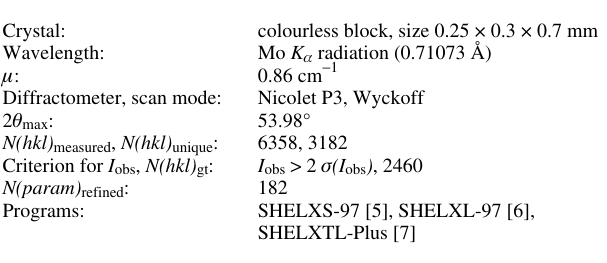
Table 1. Data collection and handling.